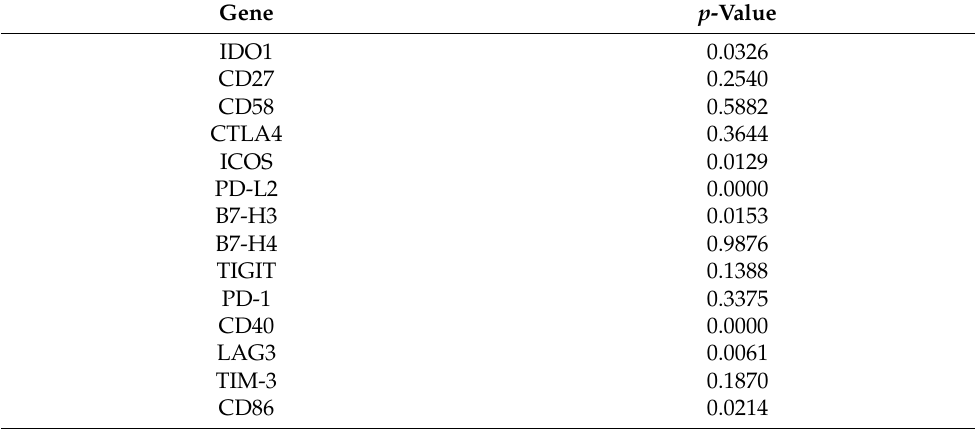
Table 2. The expression difference of immune checkpoints between low and high-risk